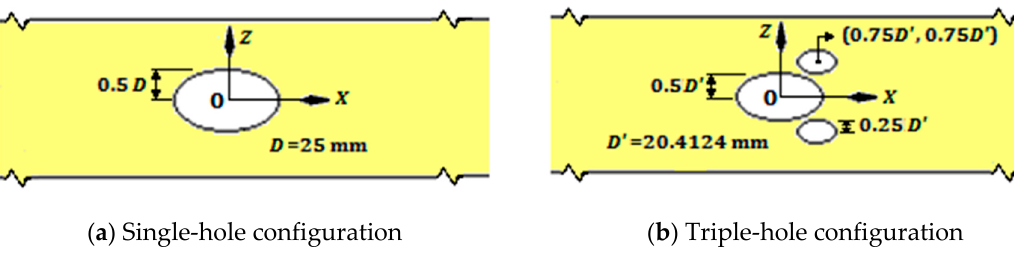
Figure 2. Schematics of the single hole and triple holes cooling hole configurations.